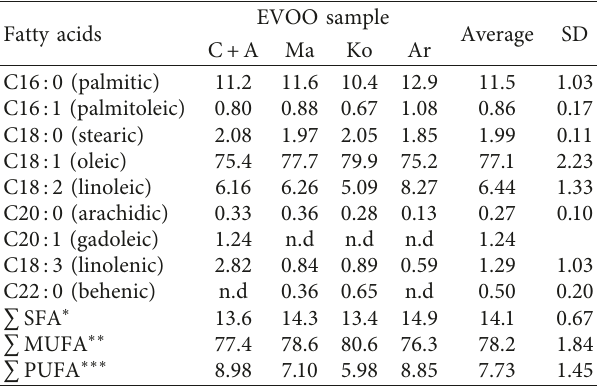
Table 2: Fatty acids profile determined in four commercial samples of